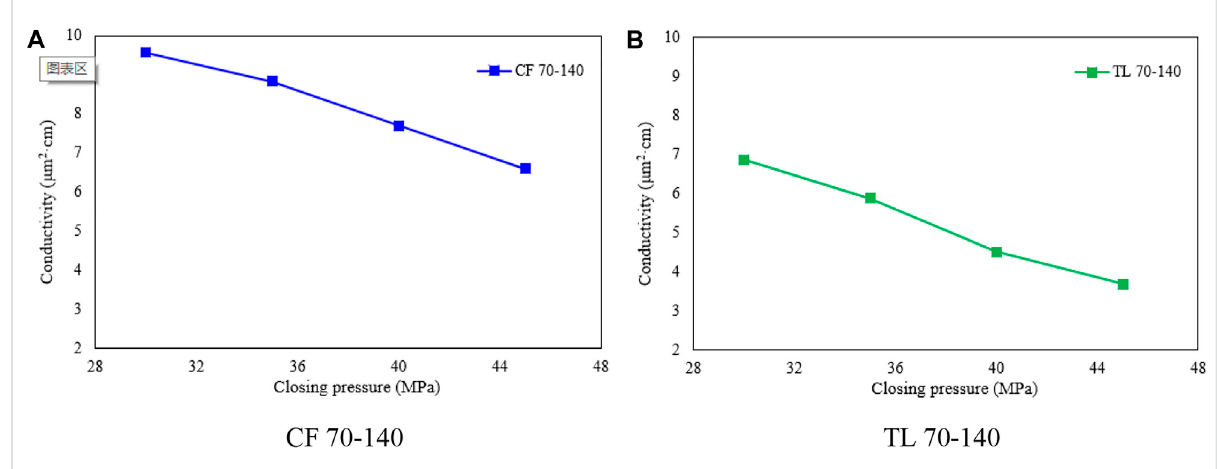
FIGURE 8 The conductivity of 70 – 140 mesh proppant varies with the closing